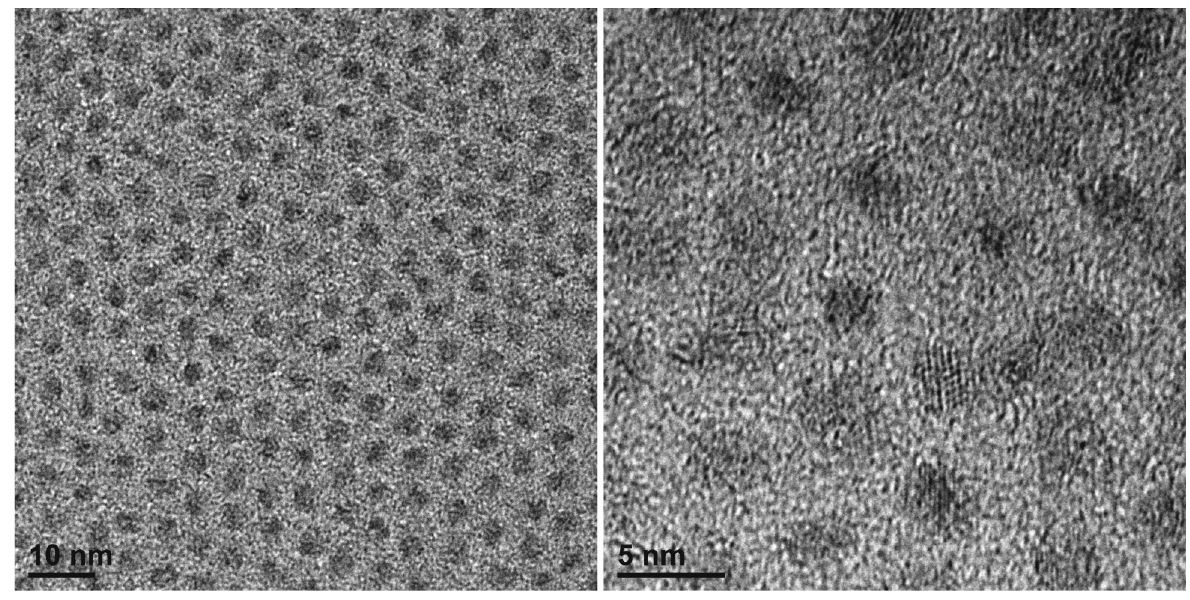
is a 300 kV transmission electron microscope instrumented with a LaB6 electron source and equipped with an ultra-high resolution pole piece (Cs = 0.6 mm). The JEOL JEM-3010 has a resolution of 0.14 nm lattice and 0.17 nm